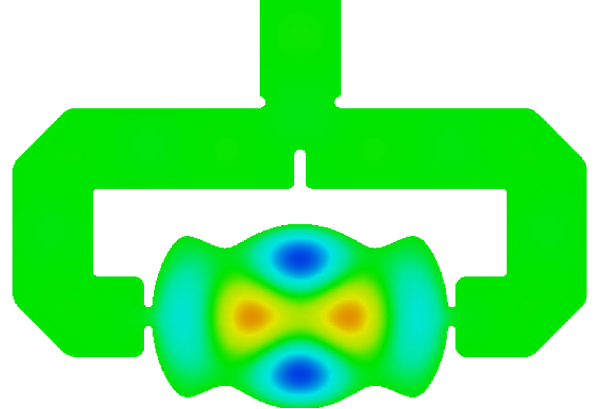
FIG. 11. Impedance measurements of the calibrated coaxial cable shorted, and with the waveguide adaptor attached to the calibrated coax and shorted by clamping an aluminum plate to it.